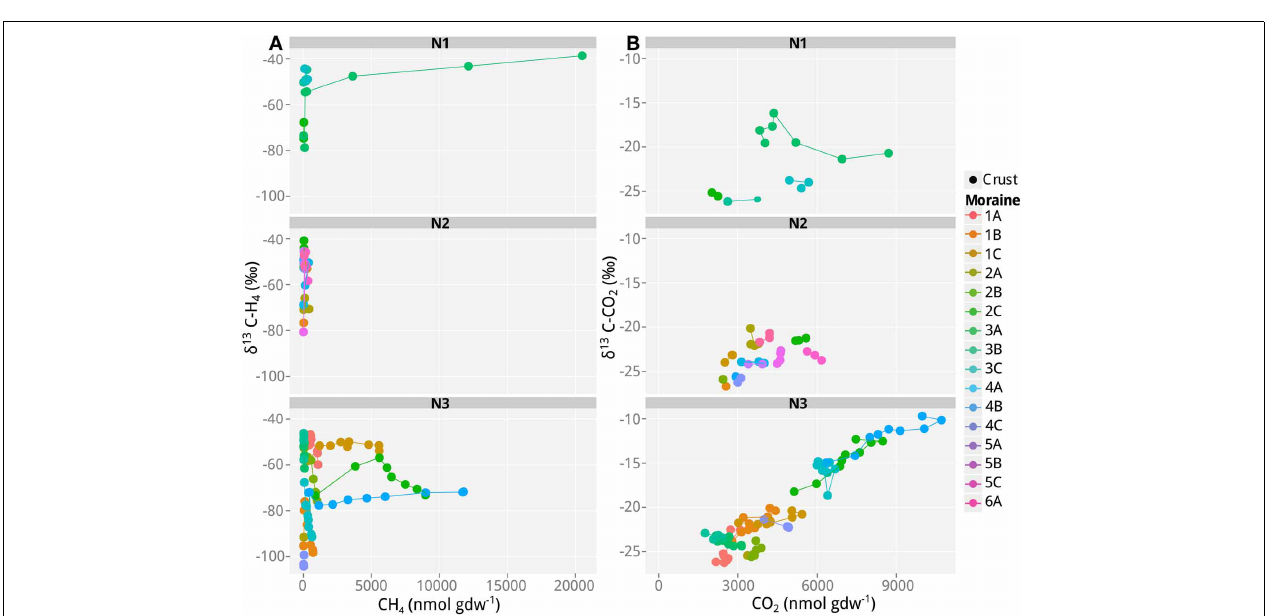
g − 1 CH 4 produced reliable δ 13 C measurements of CH 4 and are shown here. Therefore, only transects TS2 and TS3 are plotted. Temporal progression is always along the x-axis. Means of n = 3 (technical replicates).